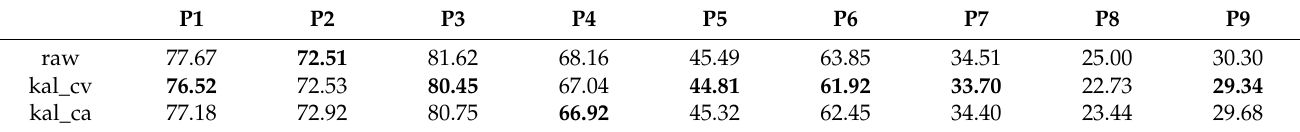
Table 2. Mean Table 2. Mean error.